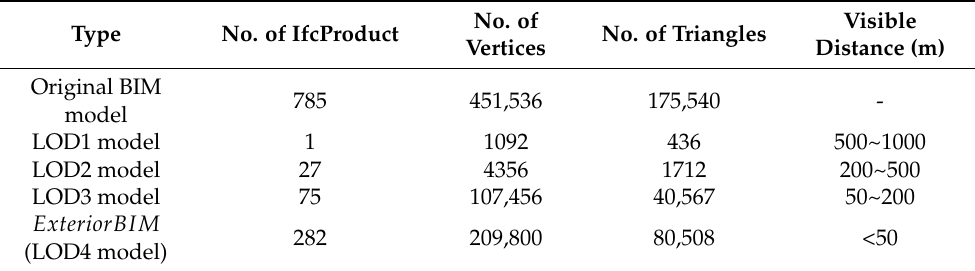
Figure 7. Oblique view of the experimental region from different distance. Table 3. Statistical results for the experimental model.